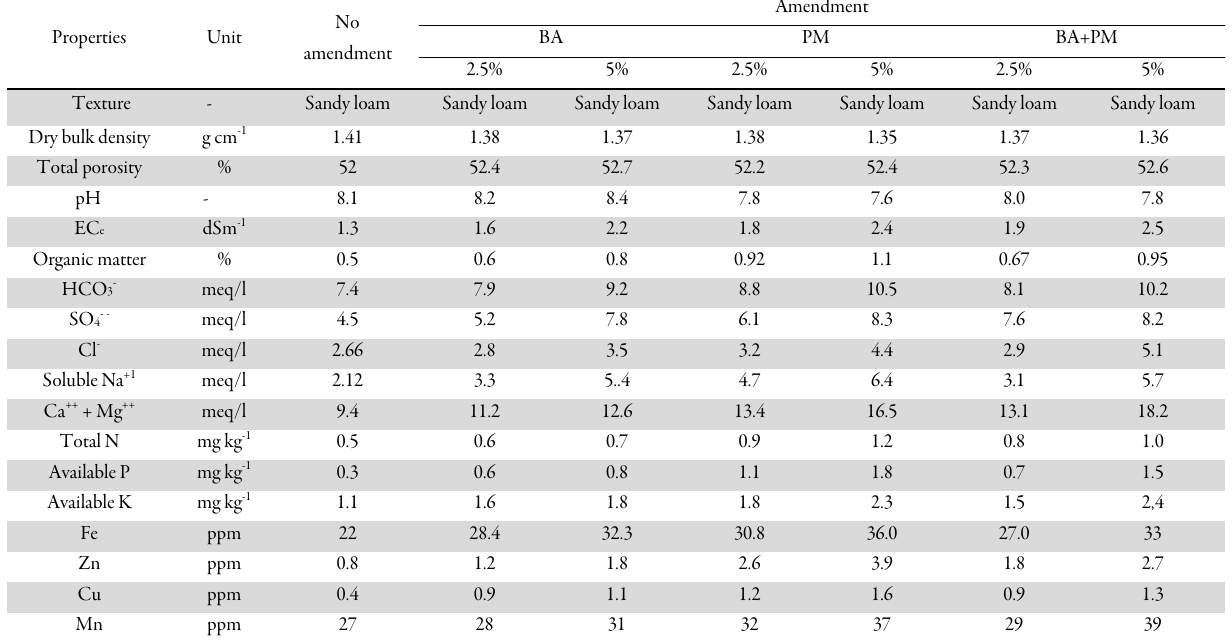
Table 4. Effect of amendment with BA and PM and seed treatment with P. indica on physical and chemical properties of the soil. All treatments include a seed treatment with P. indica